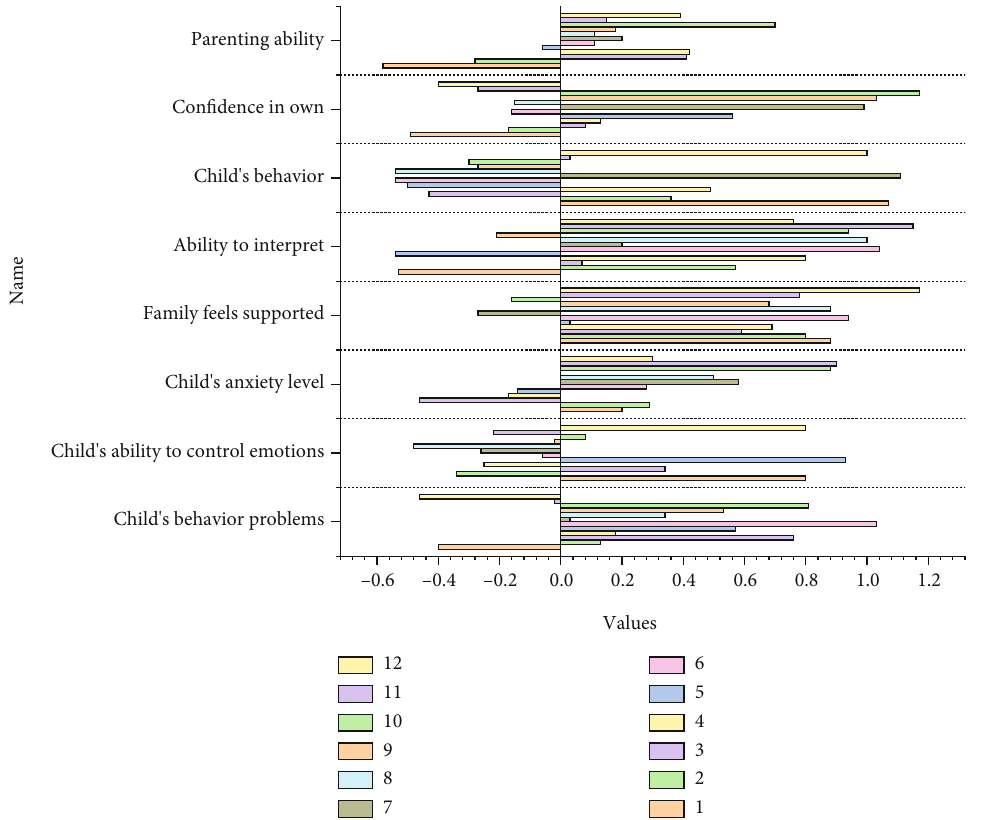
Figure 2: Intergroup comparison of the number of children reaching the embodied level by